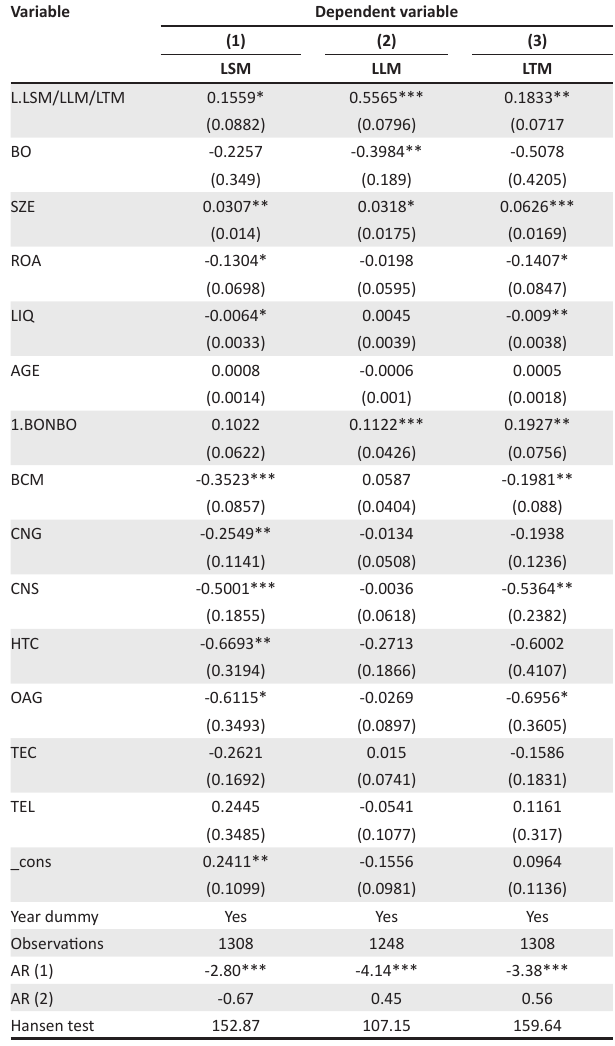
TABLE 4: The effect of black ownership on capital structure (fixed-effects and random-effects models) of companies listed on the Johannesburg Stock Exchange.